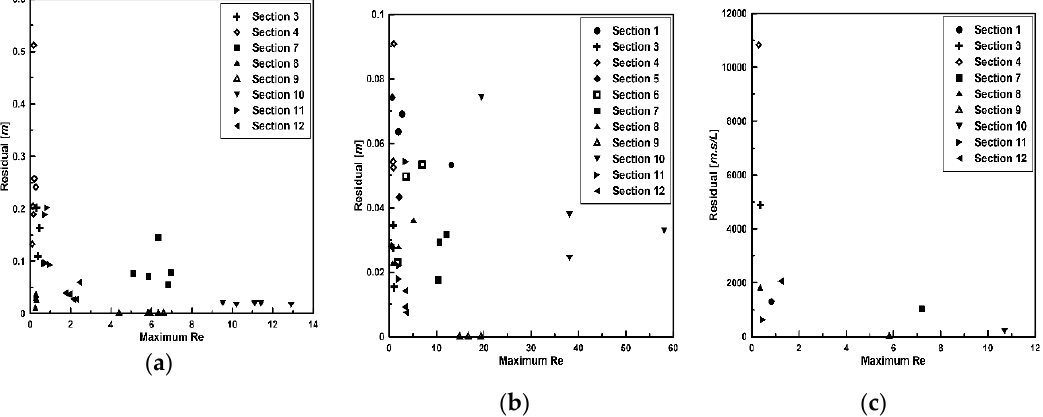
Figure 4. Relation between the residual and maximum Re for the ( a ) pulse; ( b ) slug; and ( c ) constant head withdrawal tests.